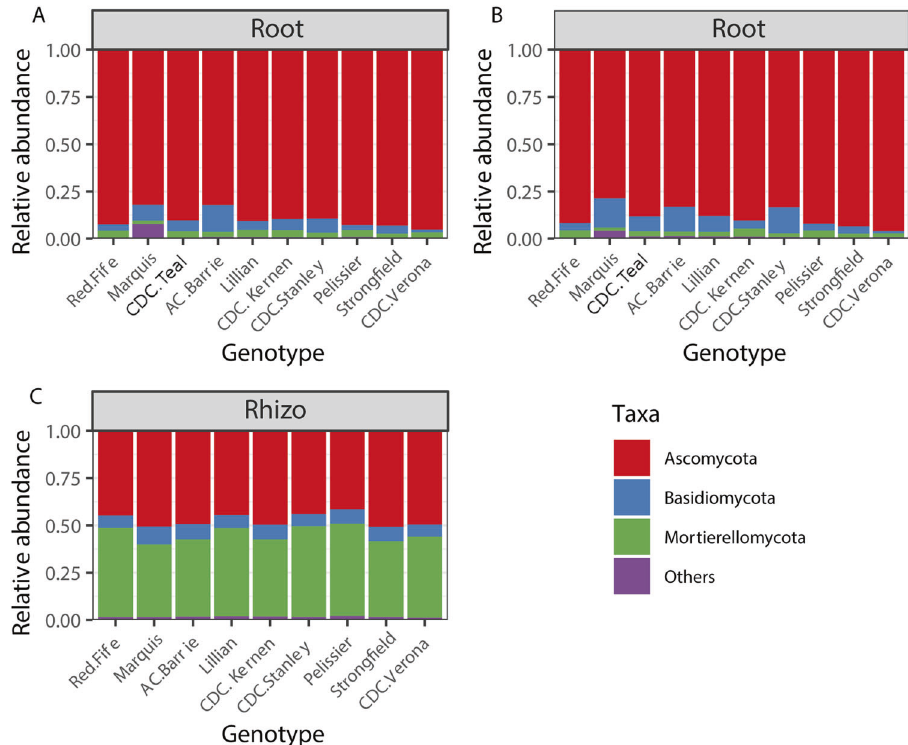
Fig. 3 Community composition of the most abundant phylum based on the ITS region amplicons for the growth stage/compartment combinations that showed a signi fi cant (P < 0.10) effect of genotypes in Table 3. ( A ) 2013, roots, stem elongation; ( B ) 2013, roots, dough development; ( C ) 2013, rhizosphere, dough